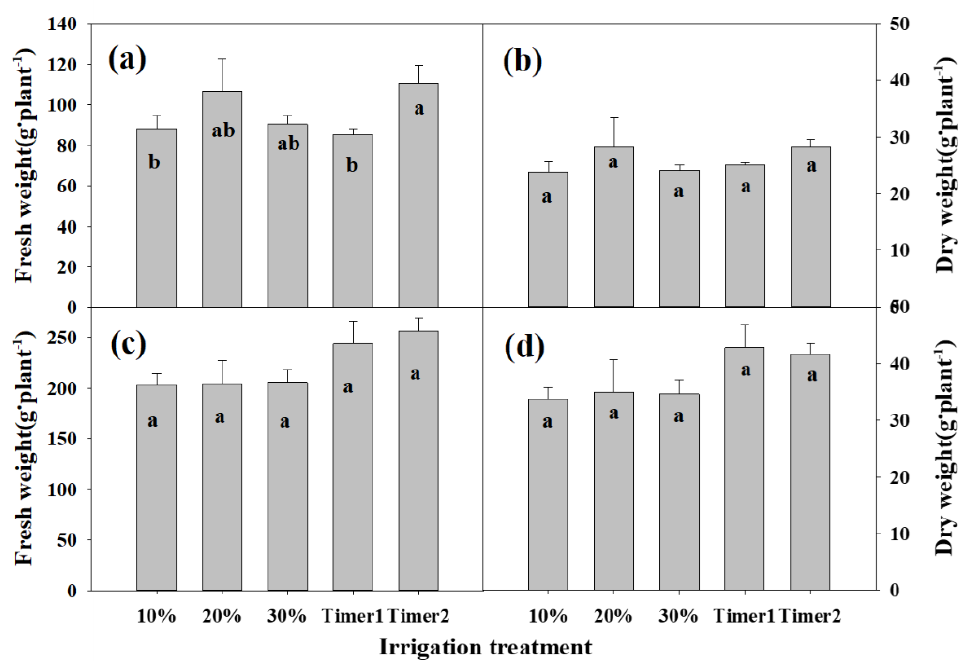
Figure 3. Fresh weight and dry weight of aerial ( a , b ) and root ( c , d ) parts of strawberry ‘Kuemsil’ as affected by the nutrient solution supplying system using different drainage rate levels and timings (Drainage rate 10%, 20%, or 30%; Timer 1, timer set for 4 applications daily; Timer 2, timer set for 6 applications daily). Vertical bars indicate standard errors of the means ( n = 15). DMRT at p < 0.05 and different letters indicate significant differences between treatments.